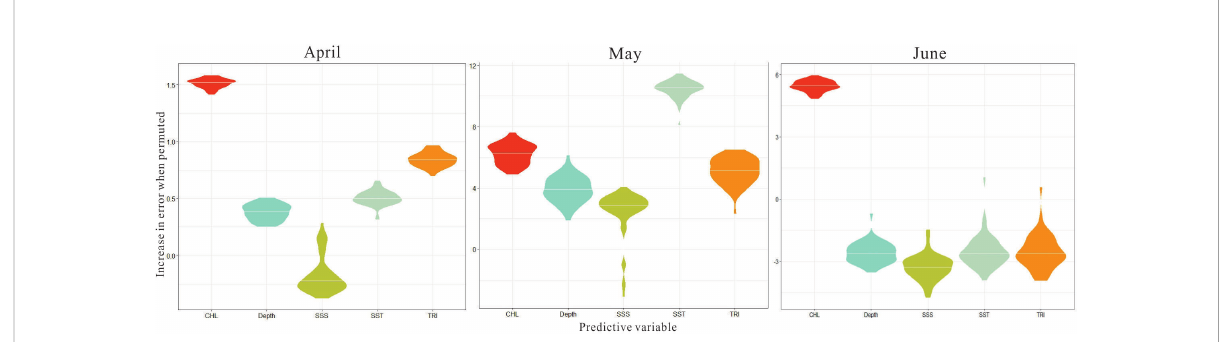
FIGURE 5 Variable importance scores among predictors from April to June by repeating SAM execution 50 times.